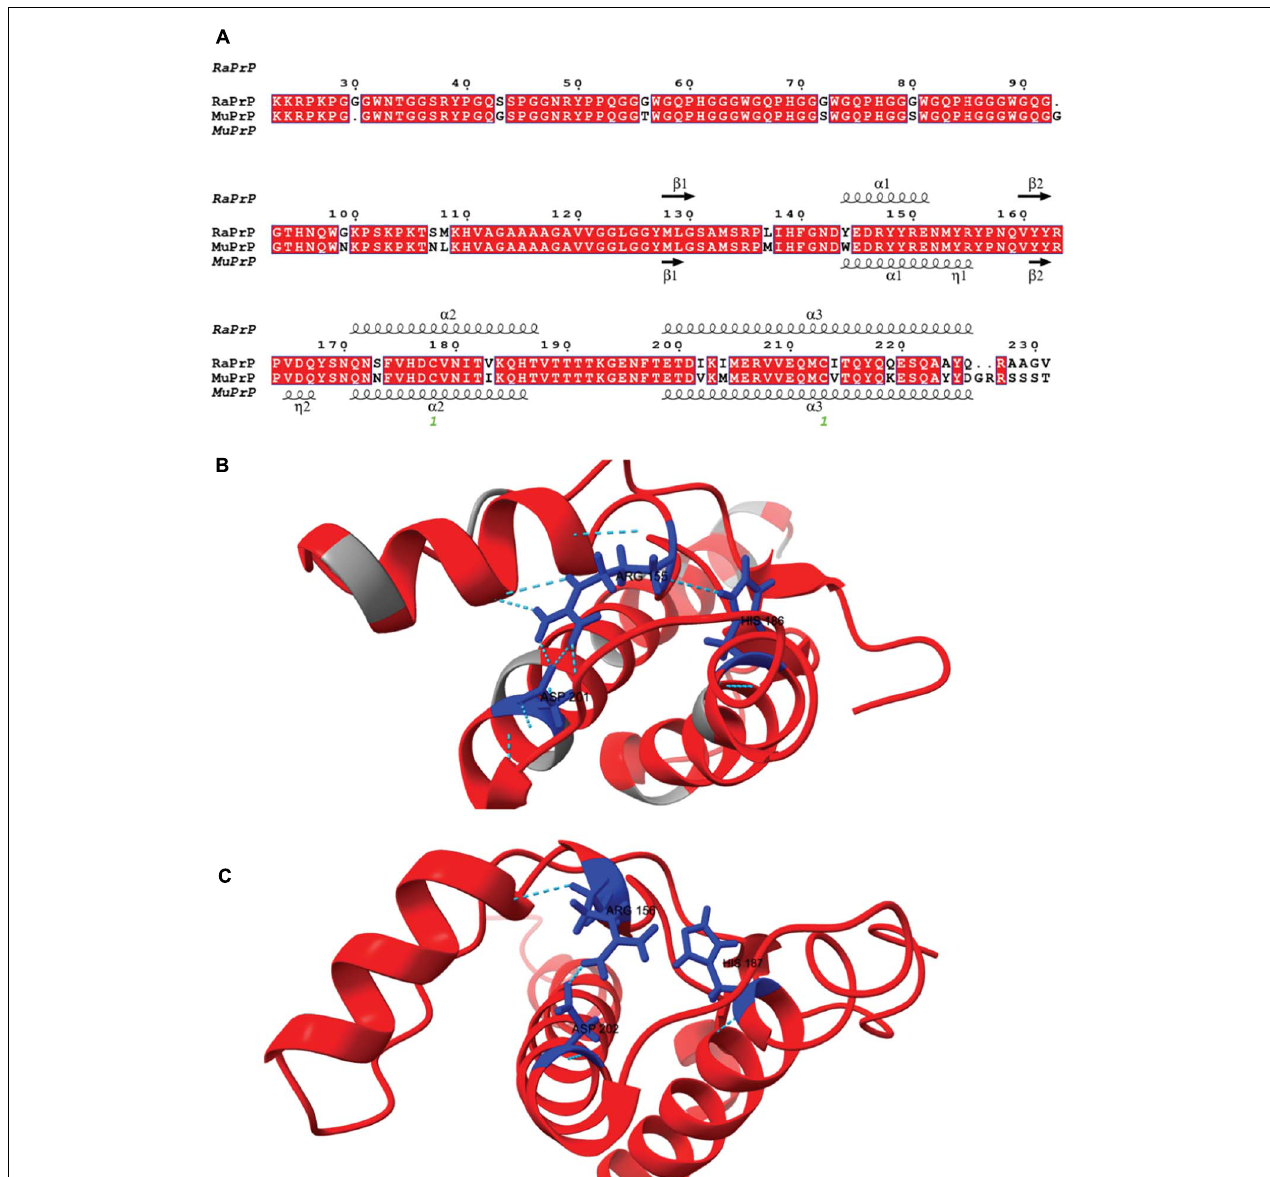
FIGURE 1 | Rabbit and murine PrP structural alignment and comparison. (A) RaPrP 23 − 231 sequence (UNIPROT Q95211) was aligned with MuPrP 23 − 231 sequence (UNIPROT P04925) using the T-Coffee server. The figure was produced with the ESPrip server, using PDB 2FJ3 for RaPrP 23 − 231 and PDB 1XYX for MuPrP 23 − 231 secondary structure depiction. Aligned amino acid residues are in red boxes to distinguish them from low similarity residues. The secondary structures (alpha-helix and beta-strands) are shown on the top of the alignment for RaPrP 23 − 231 and the bottom for MuPrP 23 − 231 . (B) RaPrP 23 − 231 3D structure is shown in red, and non-homologous residues are colored gray. ARG 155, HIS186, and ASP201 (rabbit sequence numbering) are depicted in blue, showing hydrogen bonds and saline bridges between these residues. (C) MuPrP 23 − 231 3D structure in red with ARG 156, HIS187, and ASP 202 (mouse sequence numbering) are depicted in blue. No hydrogen bond is observed between ARG 156 and HIS187, and ARG 156-ASP 202 shows one salt bridge. ChimeraX was used for structure visualization and H-bond and salt bridge